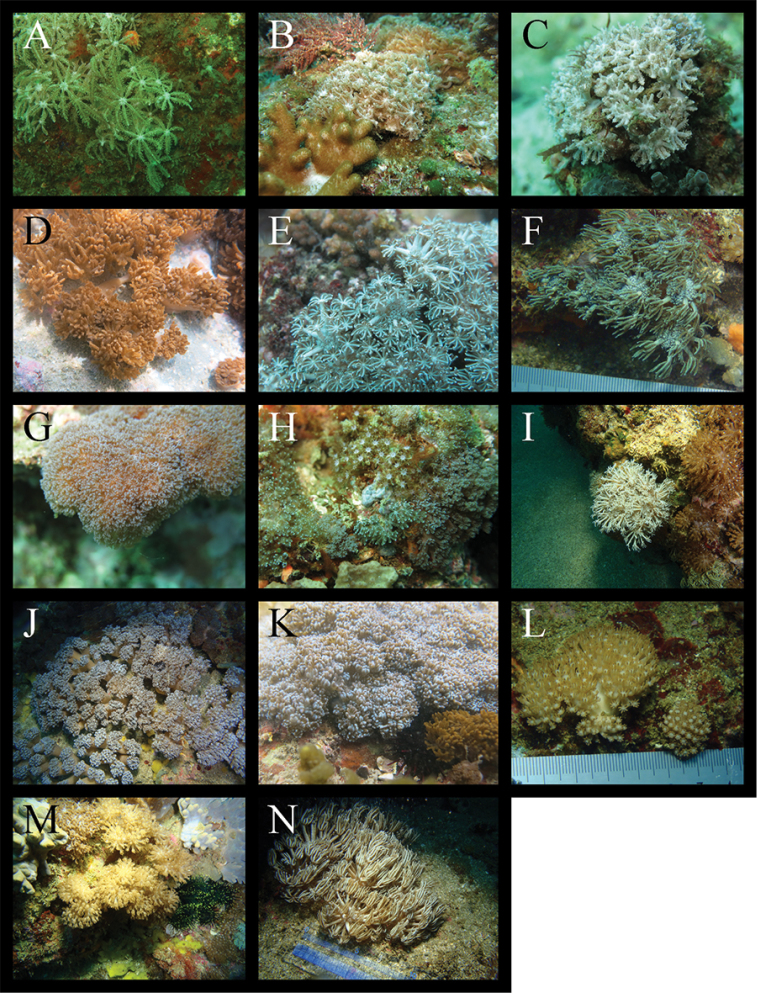
Living form of Xeniidae. AAntheliacf.glaucaBA.roseaCA.cf.tosanaDHeteroxeniacf.elisabethaeEH.medioensisFH.minutaGSympodium sp. 1 HS. sp. 2 IYamazatum sp. 1 JXenia sp. 1 KX. sp. 2 LX.novaecaledoniaeMX.kuekenthaliNX.plicata.